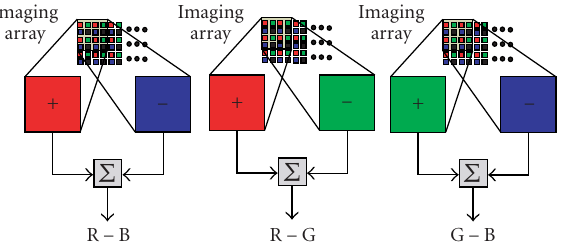
Figure 4: Color opponent computation performed by the chip. Bipolar R − B, R − G, and G − B are used to implement the HSI representation in